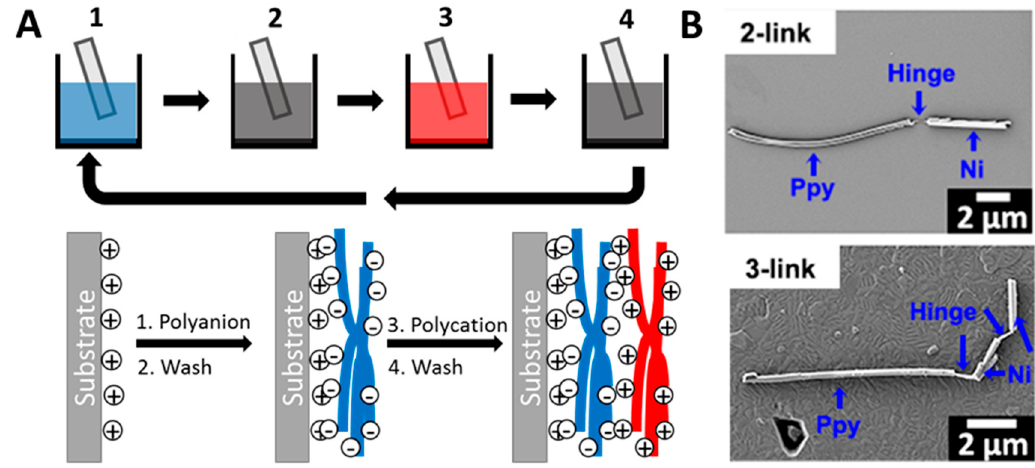
Figure 3. ( A ) Schematic illustration of the layer-by-layer assembly process. ( B ) SEM images of 2-link and 3-link nanoswimmers. Adapted with permission from Reference [104], copyright Nano Letter 2015.